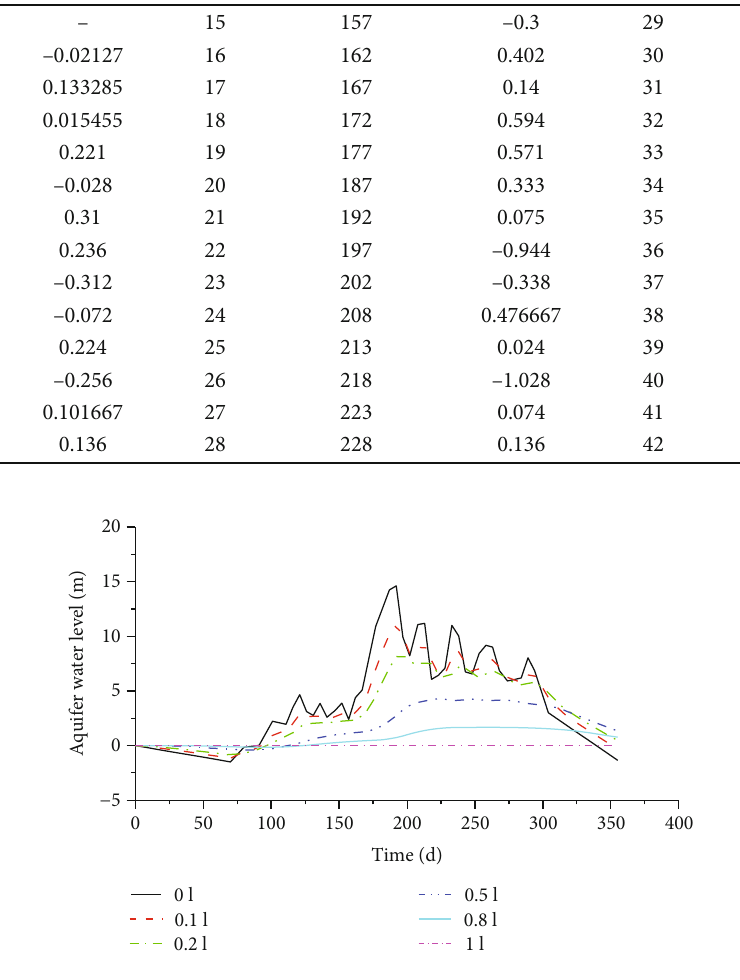
Figure 3: Hydraulic response duration curve in a con fi ned aquifer at di ff erent